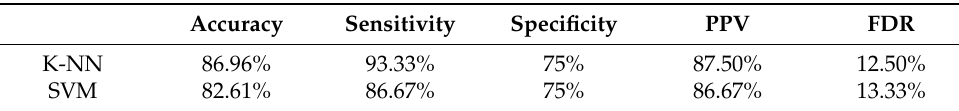
Table 5. 5-fold cross–validation performance of the two classifiers.